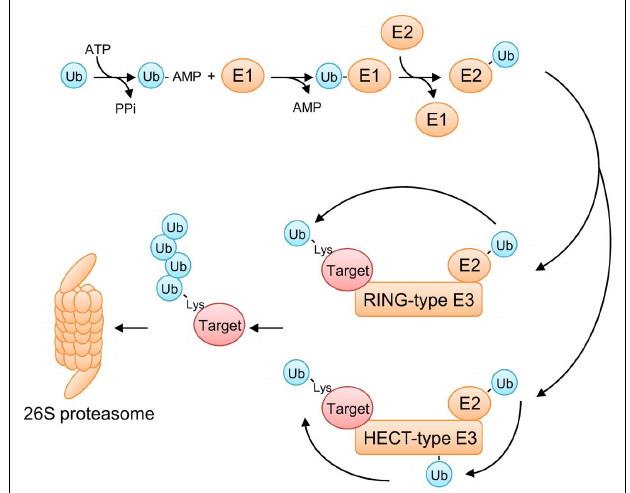
FIGURE 1 |The ubiquitin/26S proteasome system (UPS). Ubiquitination is accomplished by sequential reactions involving three classes of enzymes (E1, E2, and E3). First, a ubiquitin-activating enzyme (E1) activates a ubiquitin molecule in an ATP-dependent manner, resulting in formation of a high energy thioester linkage between E1 and the C-terminal glycine residue of ubiquitin.The activated ubiquitin is then transferred to a ubiquitin-conjugating enzyme (E2), and subsequently conjugated to a lysine residue in the target protein with the help of a substrate-specific ubiquitin ligase (E3). E3 ligases are classified into two groups, depending on their mode of action. RING finger-type E3 ligases transfer a ubiquitin moiety directly from E2 to a lysine residue of the target protein. HECT-type E3 ligases conjugate ubiquitin in two steps: first, a ubiquitin moiety is transferred from E2 to the HECT domain of a HECT-type E3 ligase and, then, to a lysine residue of the target protein. Lys11- or